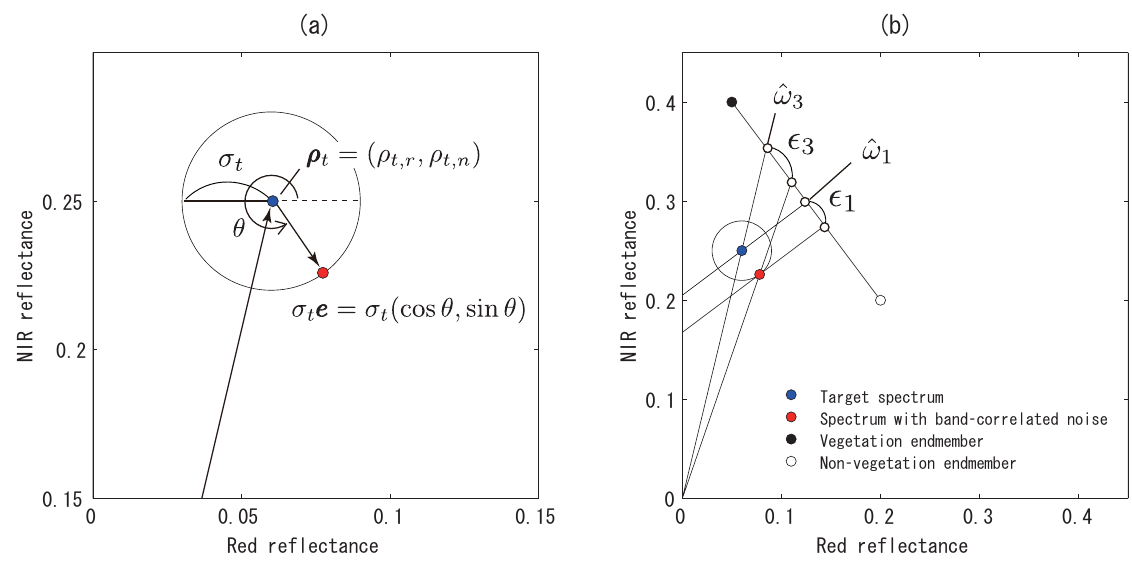
Figure 1. Error model in the measured spectrum ( a ) and the errors propagated in the FVCs by algorithm-1 and -3, ( b ) in the red-NIR reflectance space. In ( a ), the blue dot indicates the target spectrum and the red dot indicates the band-correlated noise, a distance σ the target spectrum. The circle around the blue dot indicates the choices of band-correlated noise. In ( b ), the FVCs and propagated errors for the two algorithms are indicated by empty circles on the line spanned by the vegetation and non-vegetation endmember